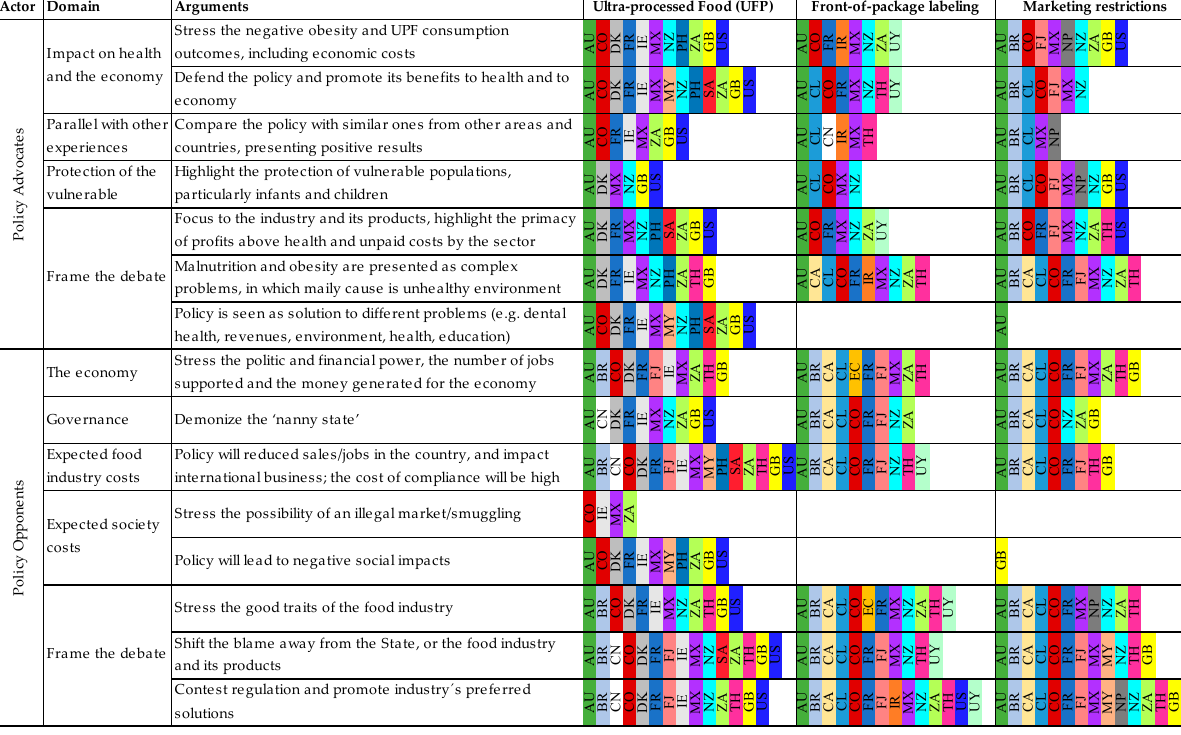
Figure 1. Discursive strategies by actors and country.